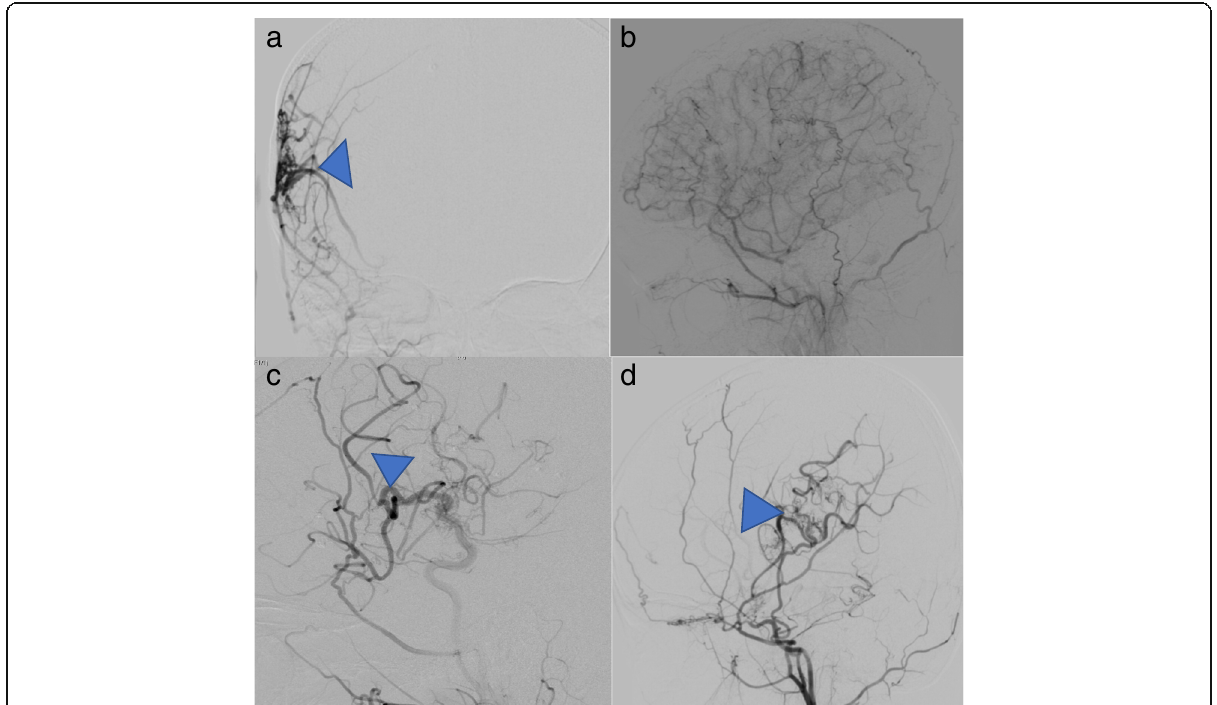
Fig. 4 a MCA filling from the anastomosis. b MCA filling from an ECA injection. c Filling of the external carotid artery (ECA) circulation with the bypass section seen along with d ECA circulation with MCA filling as